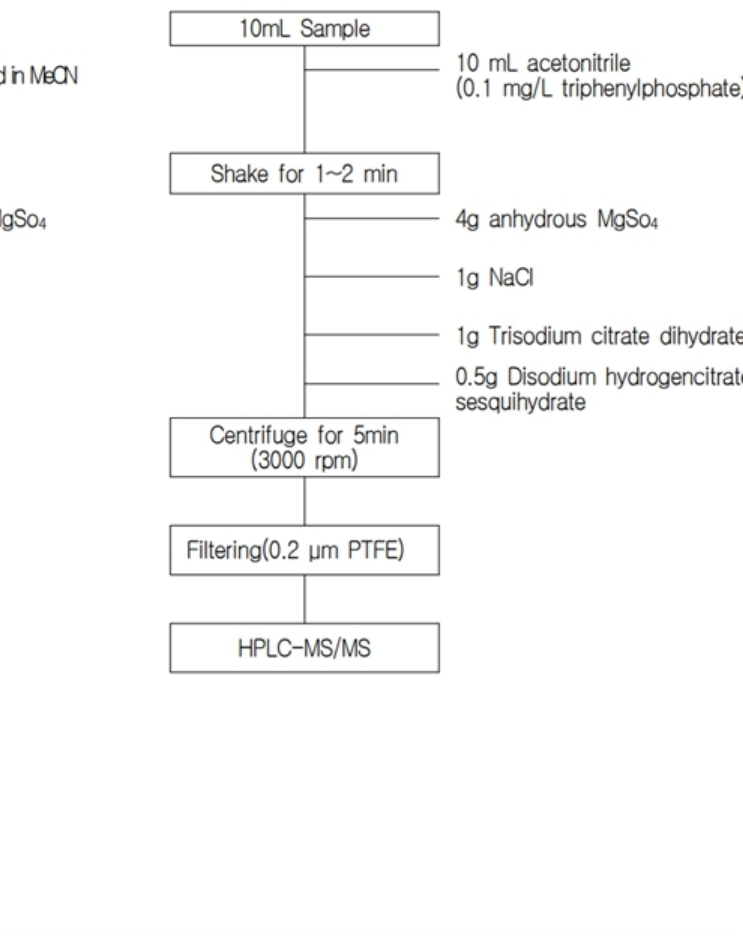
Figure 3. Pretreatment method for analyzing residual pesticides of herbal decoctions. PTFE: polytetrafluoroethylene; GC: gas chromatography; LC: liquid chromatography; MS: mass spectrometry.